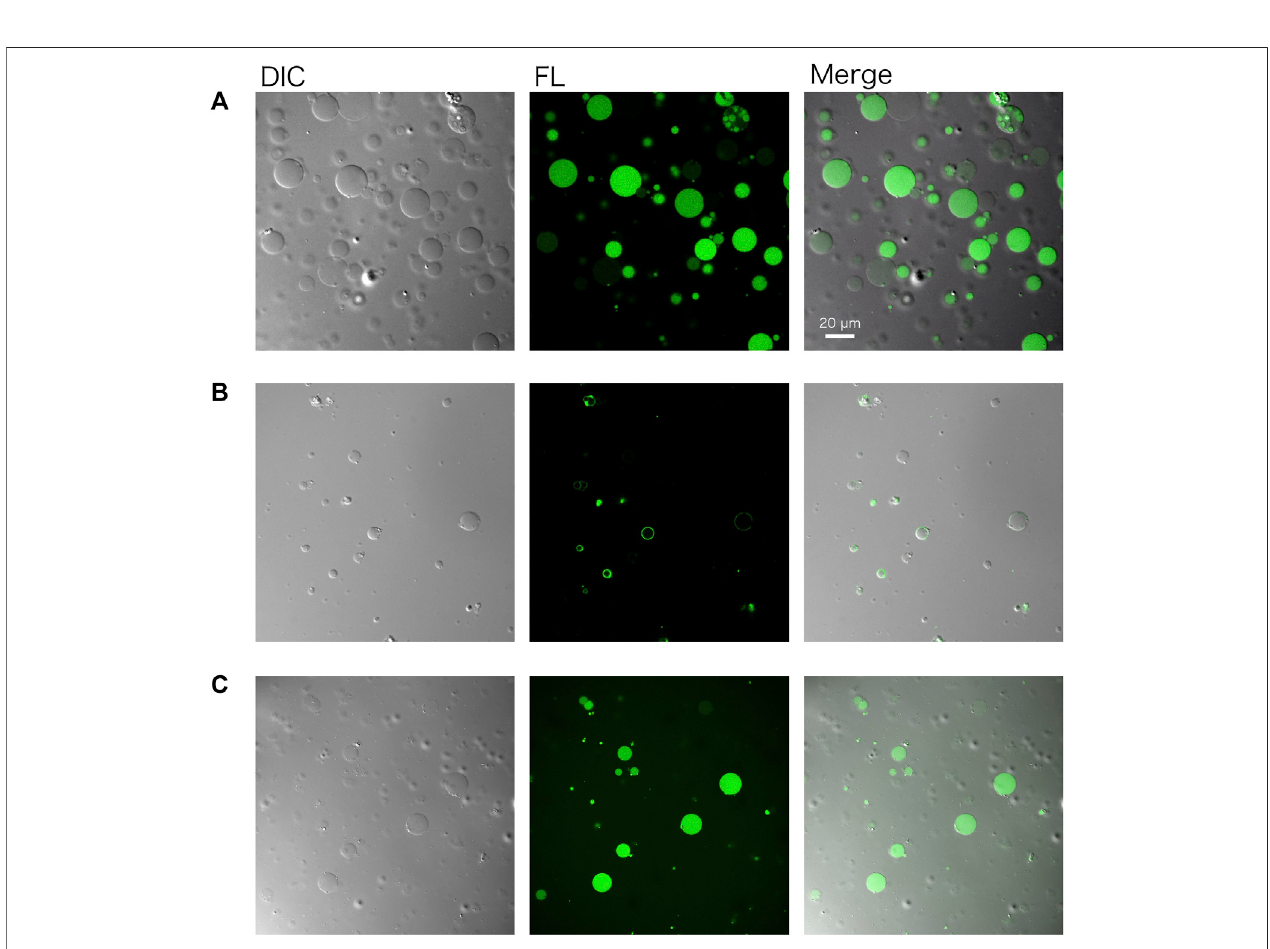
FIGURE 3 | Confocal microscopy images of arti fi cial cells. (A) Green fl uorescent protein (GFP) and (B) a fusion protein of PlsY-GFP were synthesized in GVs. (C) GFP was synthesized using the lyophilized and rehydrated PURE system inside GVs. In any case, the GV membrane was composed of POPC: POPG (50:50 mol%). Images were obtained using a Nikon confocal microscopy A1R system. DIC: differential interference contrast, FL: fl uorescence image.